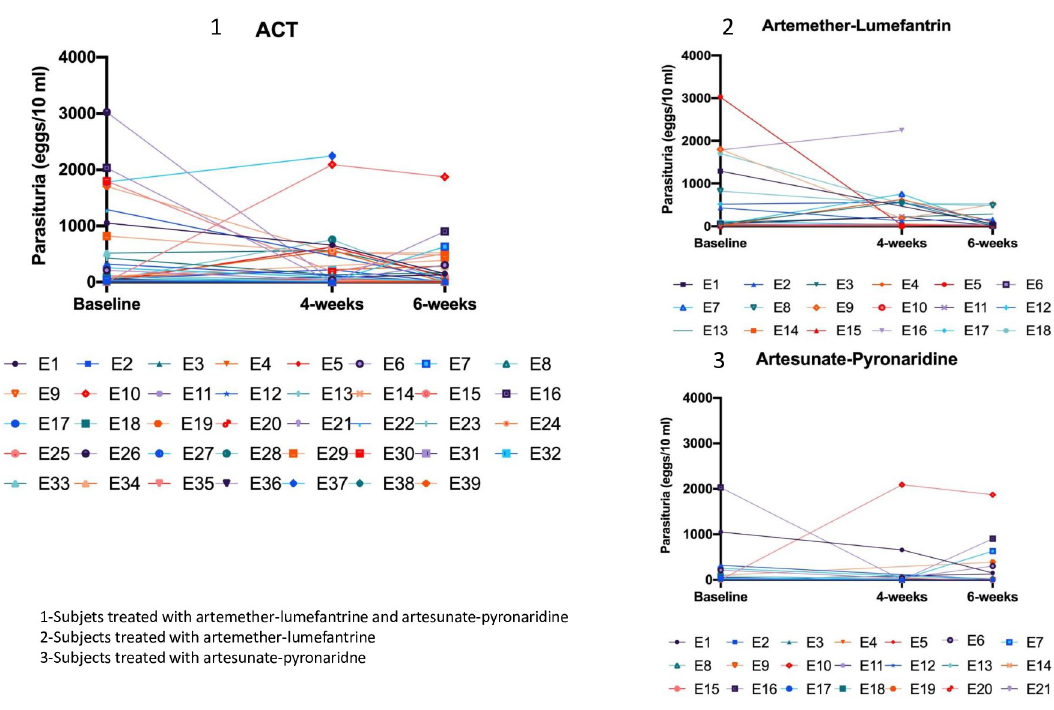
Table 4. Baseline characteristics of cured and non-cured participants treated with artesunate-pyronaridine. Subjects with eggs Subjects with egg Subjects with egg Subjects with egg present during FU clear at D42 clear at D28 clear at D28 & D42 n = 7 n = 7 n = 9